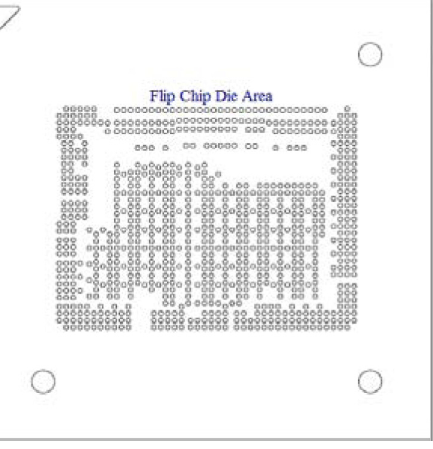
Figure 1. FCCSP test vehicle bonding diagram